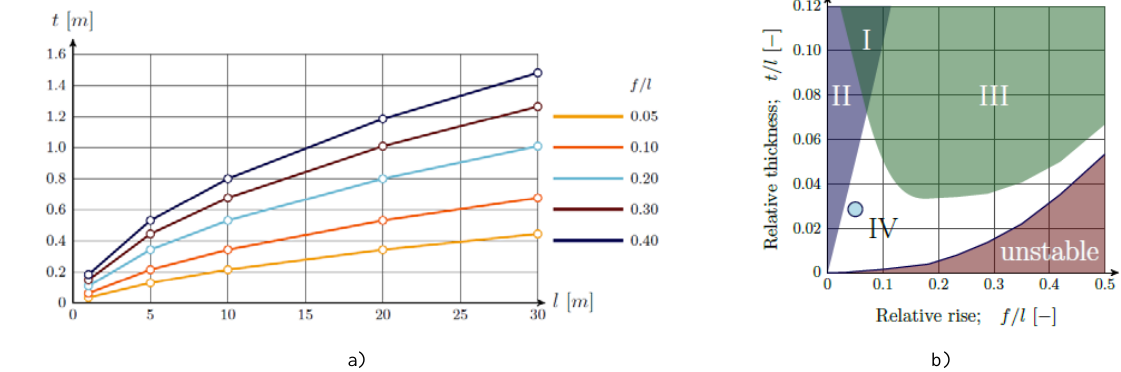
Fig. 7 Design graphs for dry-stacked glass masonry bridges; a) Required deck thickness as a function of the span, for several f/l-ratios; based on a geometrical safety factor of 2 and an asymmetrical crowd load, in accordance with the NEN-EN 1991; b) General geometry categories for stability. The blue dot indicates the geometry of the TU Delft bridge.